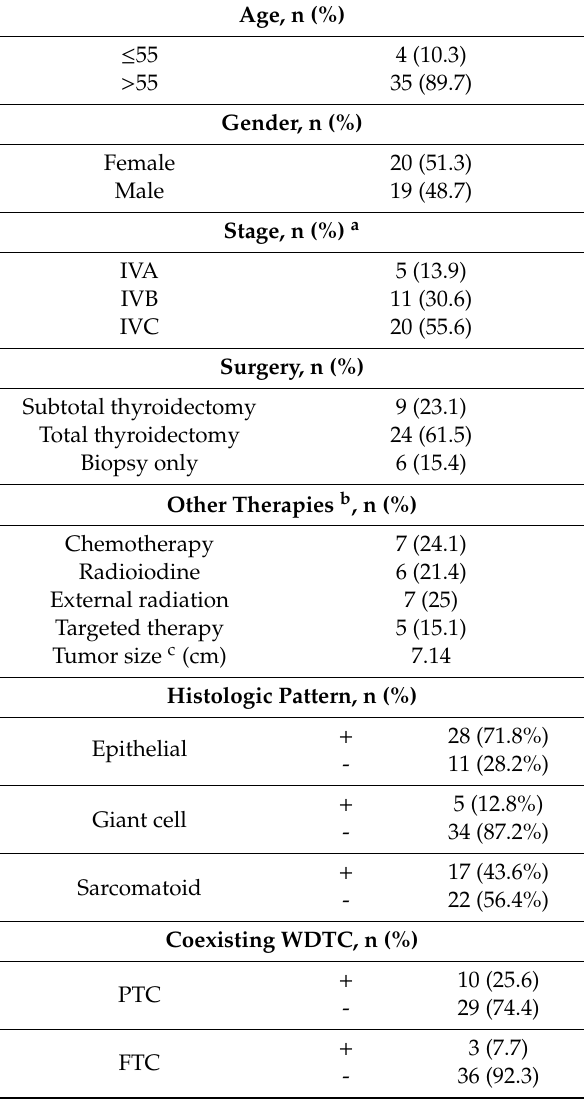
Table 1. Summary of clinicopathological features of 39 anaplastic thyroid carcinoma cases.